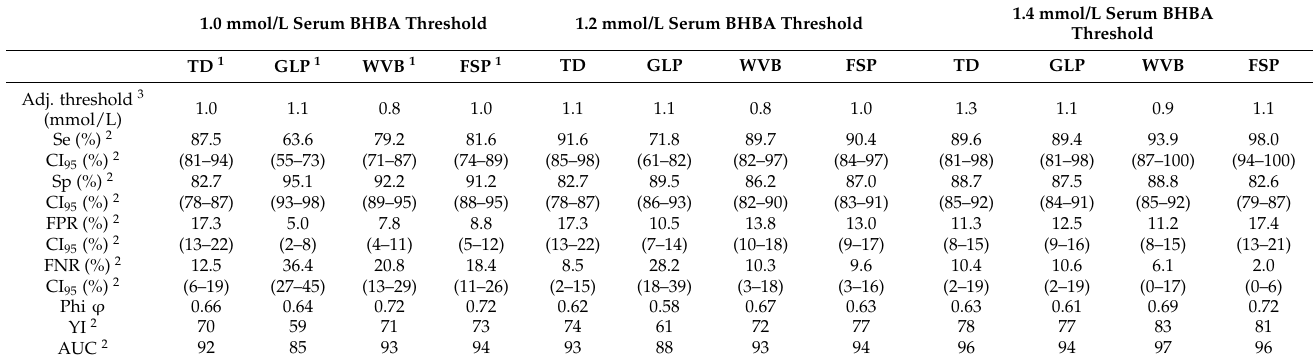
Table 6. Performance of four handheld devices 1 measuring β -hydroxybutyrate (BHBA) in whole blood with optimized device thresholds calculated with the receiver operating characteristics curve (ROC) analysis to detect subclinical ketosis, based on thresholds of ≥ 1.0, ≥ 1.2, and ≥ 1.4 mmol/L BHBA in